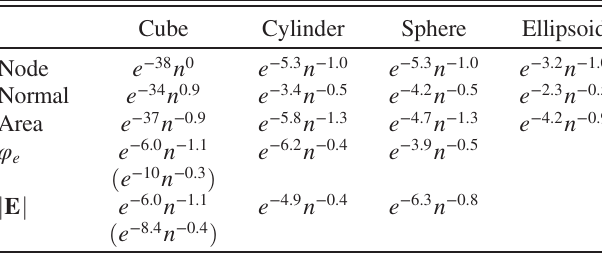
TABLE II. Error scaling in the model geometries, electric potentials, and fields. The terms in parentheses correspond to the results using Neumann boundary